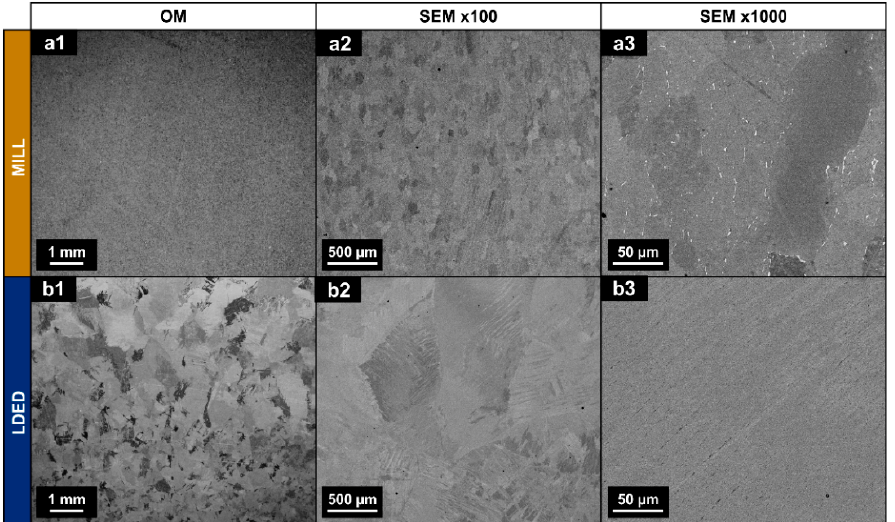
Figure 3. Optical images ( a1 , b1 ) and backscattered SEM micrographs ( a2 , a3 , b2 , b3 ) of a longitudinal section of MILL ( a1 – a3 ) and LDED ( b1 – b3 ) samples.